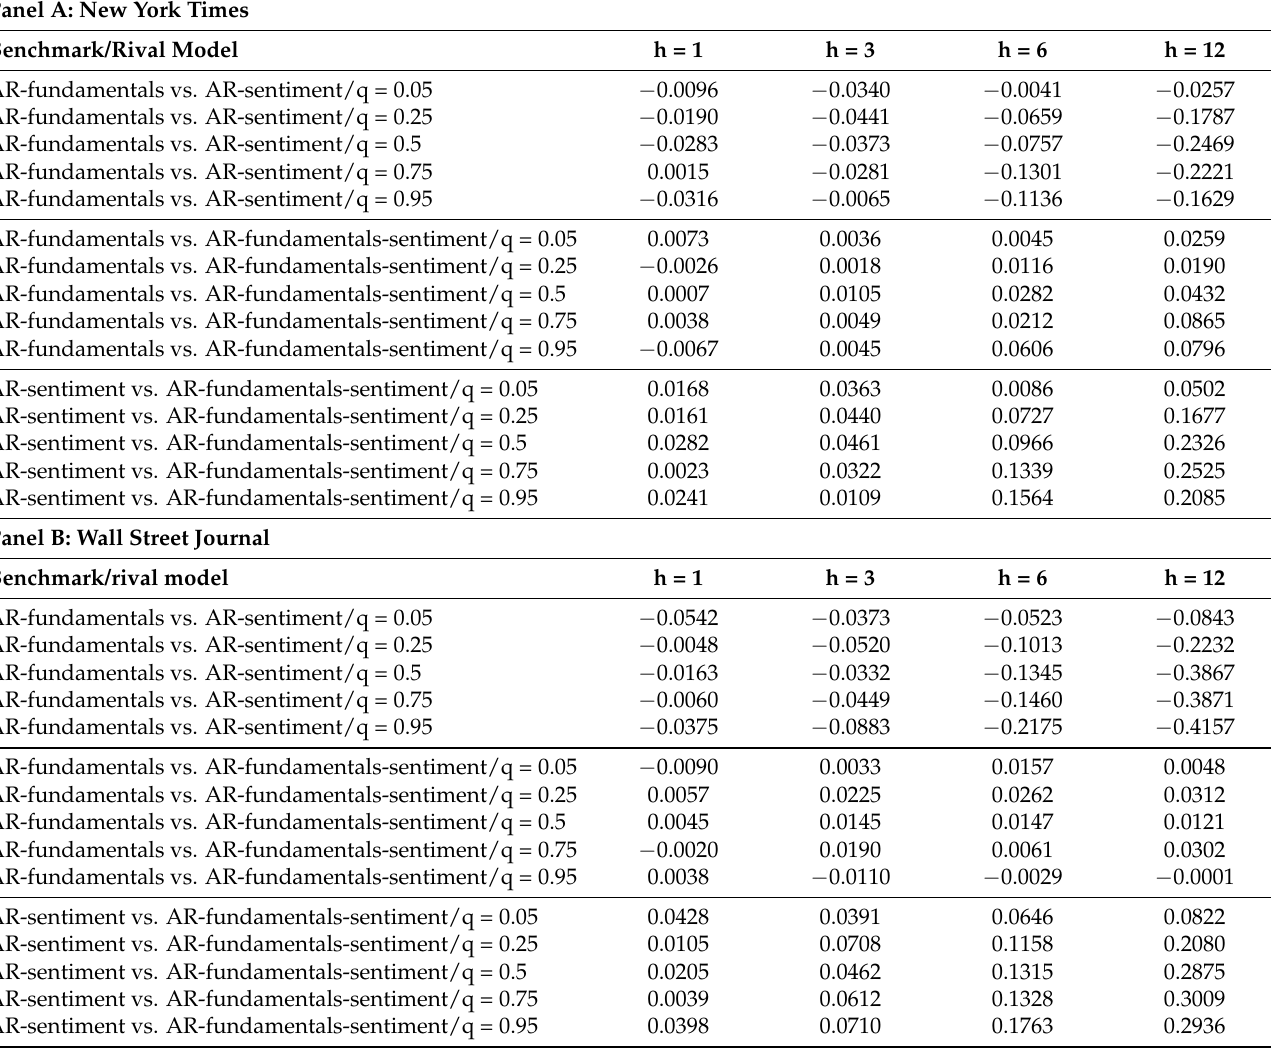
Table A5. Results for AR(10)